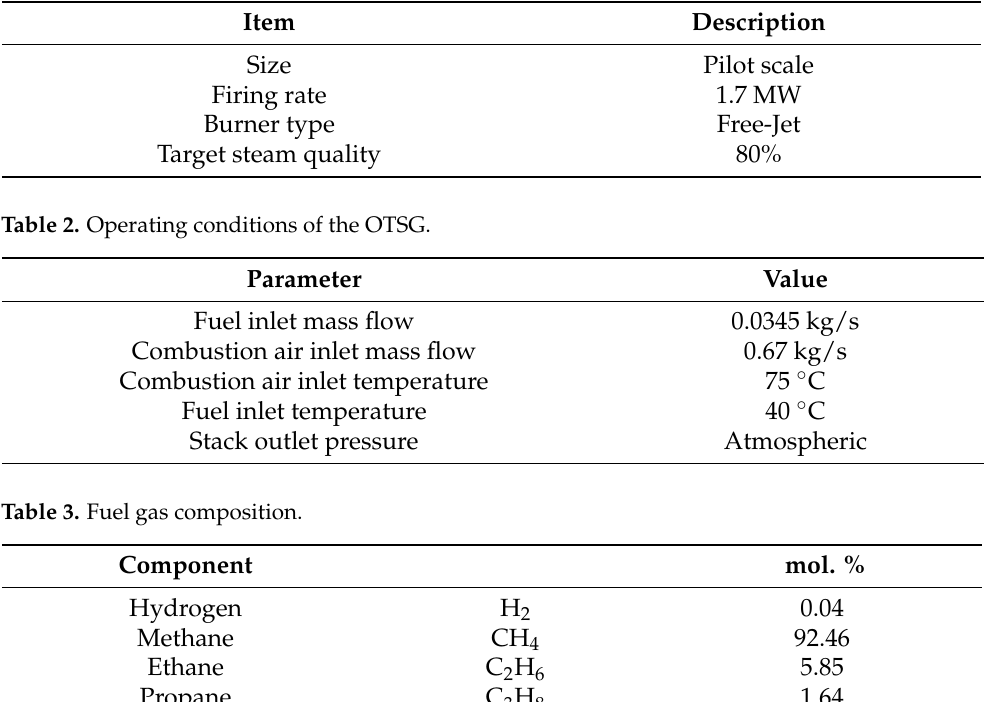
Table 1. OTSG characteristics.